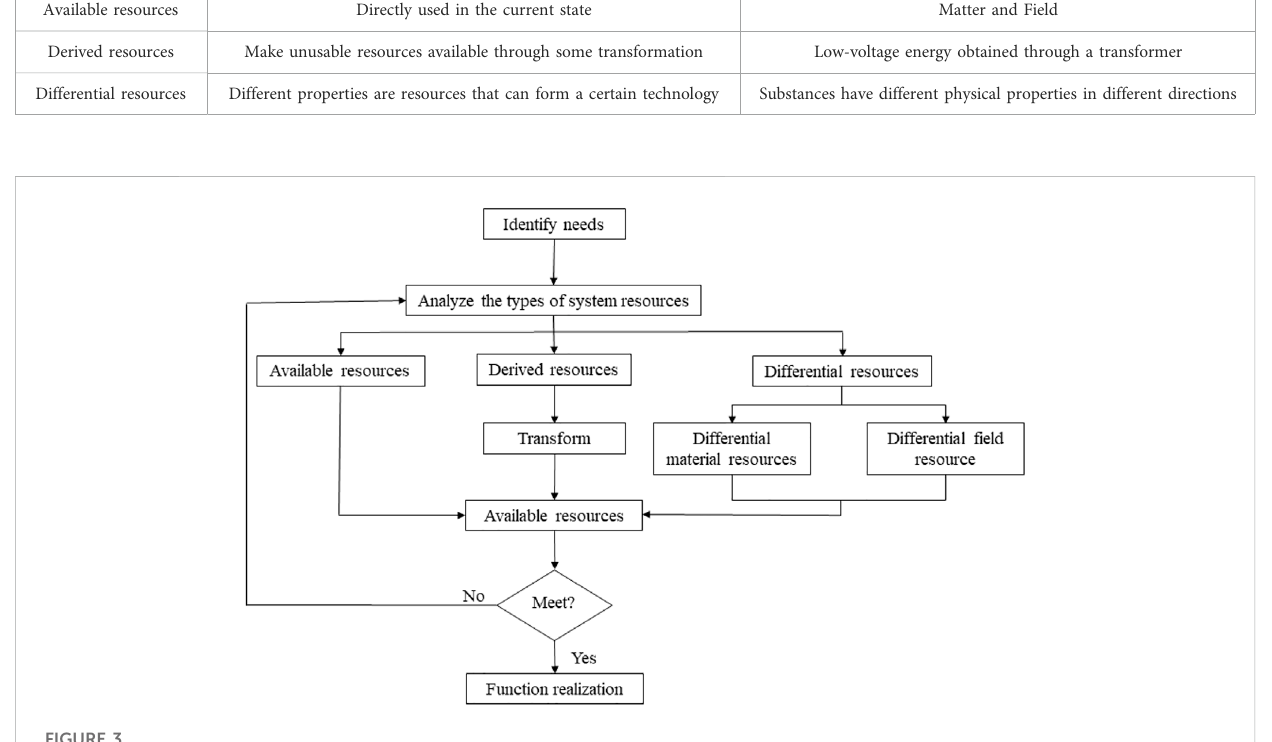
FIGURE 3 Comprehensive utilization of system